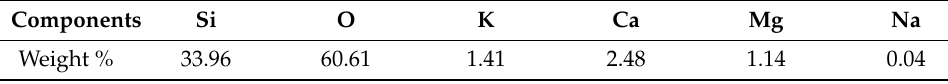
Table 2. Results of the EDS analyses.